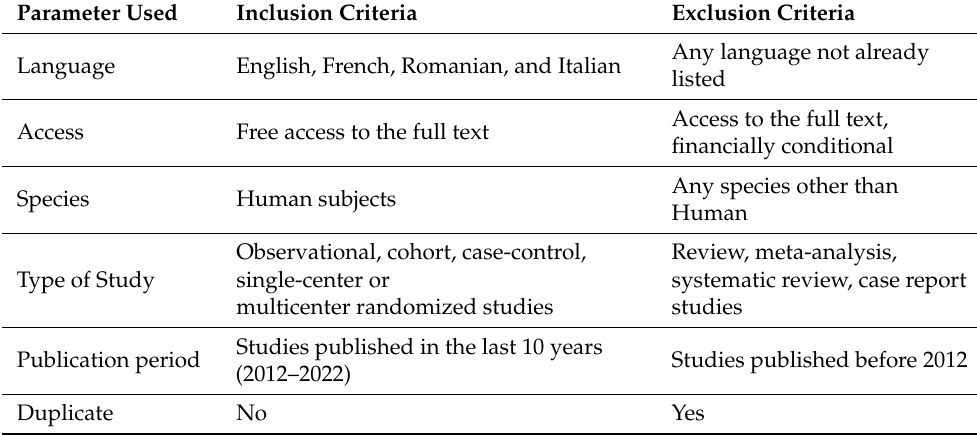
Table 1. Inclusion